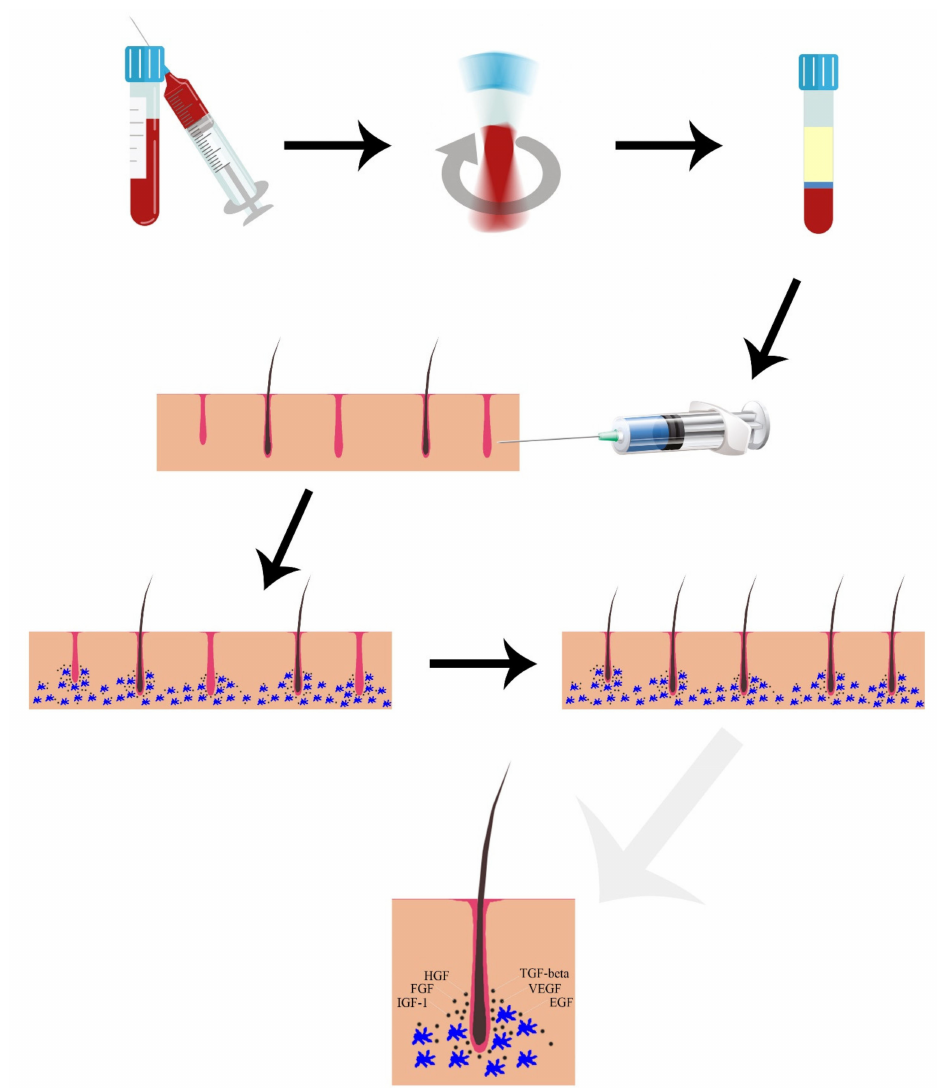
Figure 1. Mechanism of action of PRP in FAGA. The release of VEGF, PDGF, EGF, TGF- β , and FGF promotes angiogenesis, providing hair follicles with nutrients and oxygen. VEGF = vascular endothelial growth factor; PDGF = platelet-derived growth factor; EGF = epidermal growth factor; TGF- β = transforming growth factor beta; FGF = fibroblast growth factor; HGF = hair growth factor; IGF-1 = Insulin-like growth factor 1. Vector files downloaded from